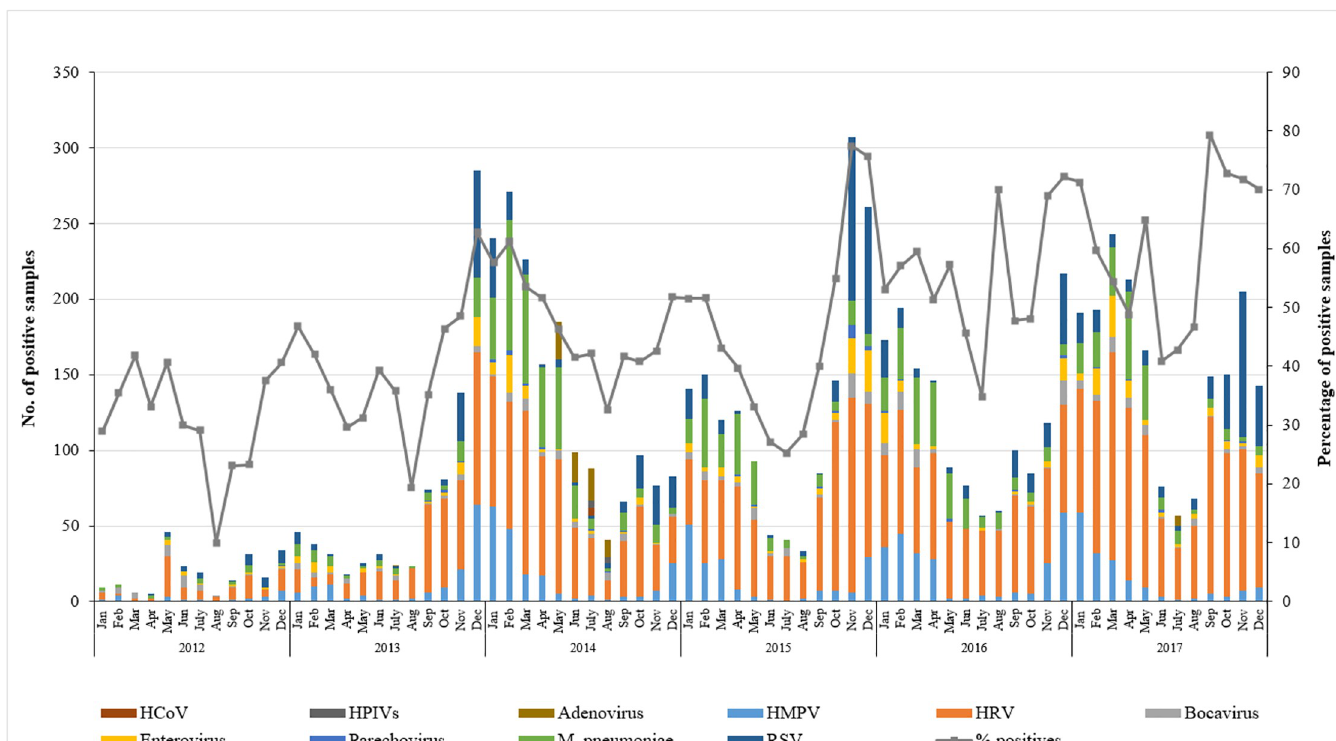
Fig 4. Seasonality of all ILIs causing pathogens. The number of positive samples for each pathogen was calculated per month from 2012 to 2017. The percentage of positive cases was calculated out of the total tested samples (n = 37,929).